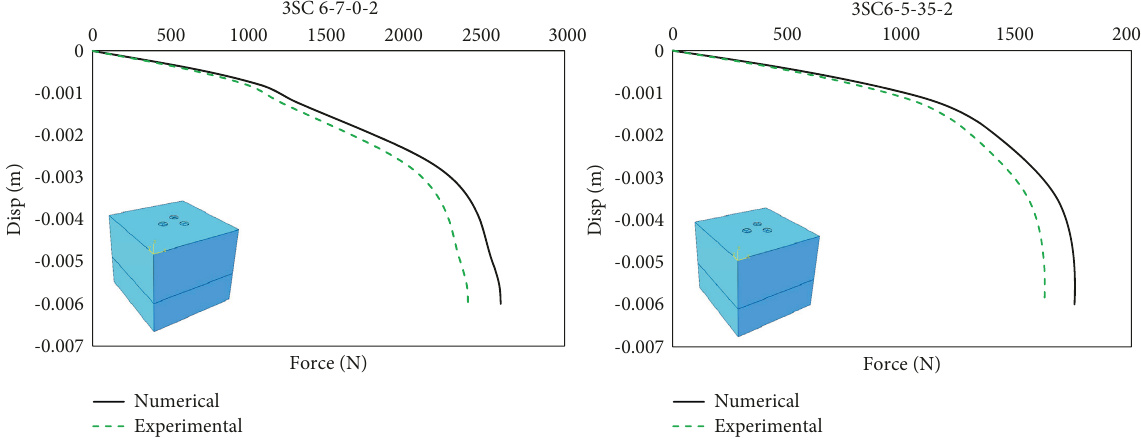
Figure 12: Force-displacement diagram related to models 3SC6-5-35-2 and 3SC6-7-0- in both numerical and laboratory